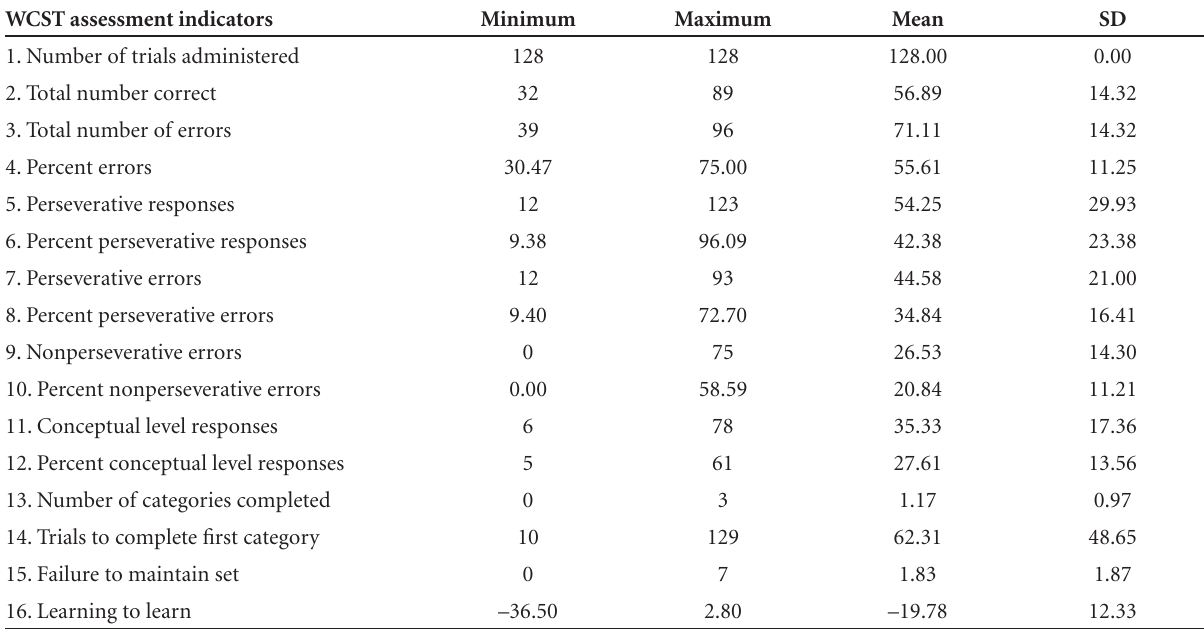
Table 2. Descriptive results for assessment indicators of the WCST in elderly persons with AD (n=36). WCST assessment